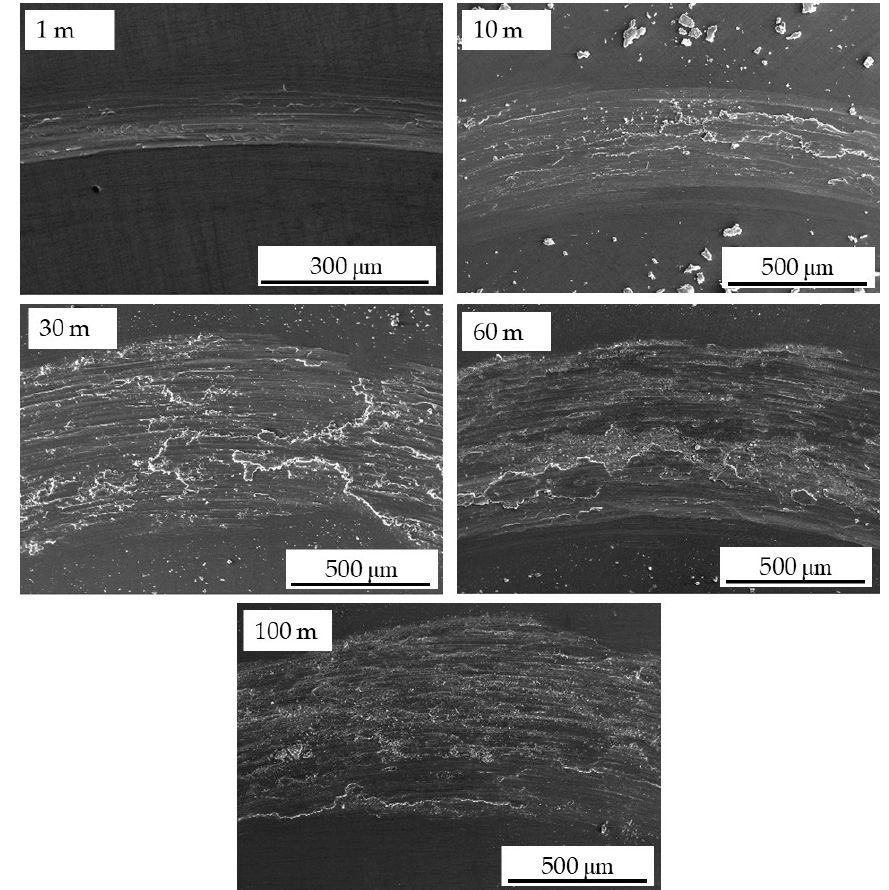
Figure 8. SEM images of the worn track at various sliding distances.